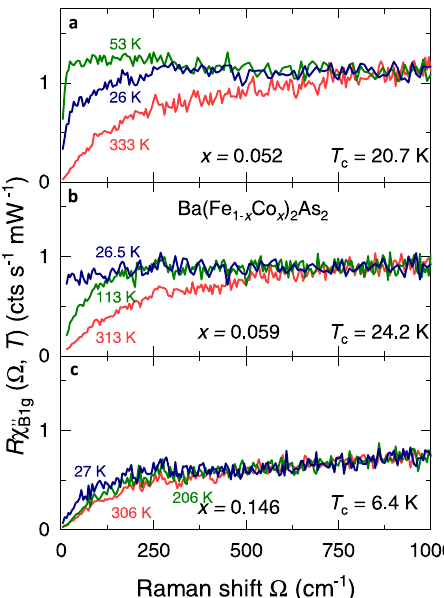
Fig. 1 Temperature and doping dependence of the Raman response. ð Ω ; T Þ in B Depicted is the Raman response function R χ 00 1g symmetry (1-Fe B1g unit cell) at selected doping concentrations x and temperatures T where Ω = ω − ω i s stands for the difference of the incident and scattered photon energy ω i and ω s , respectively. T c refers to the superconducting transition temperature. a For the underdoped compound with x = 0.052, the low- frequency pile-up attributable to classical critical fl uctuations exhibits a maximum above the nematic transition and decreases toward T c . b Close to optimal doping with x = 0.059, the low-frequency response increases monotonically on cooling toward T c . c For a sample with x ≫ x c , The temperature dependence is weak at all